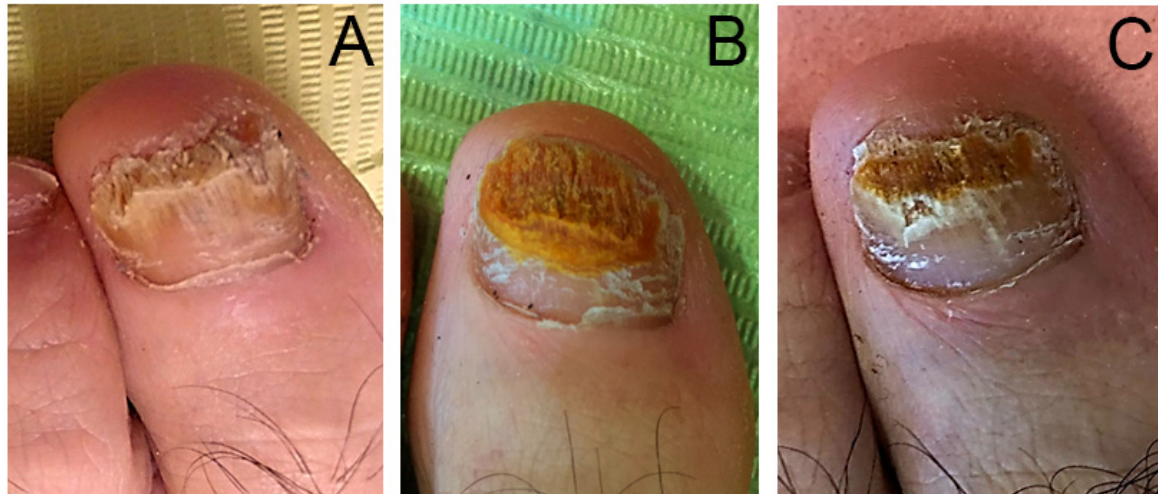
Figure 3. Evolution of the nail during treatment with 60% nitric acid of distal subungual onychomycosis (DSO) ( A before– C after). Severe onychomycosis according to the OSI, pre-treatment. Improvement after treatment during sessions was observed ( A – C ) although the OSI score did vary post treatment maintains the same level of severity.